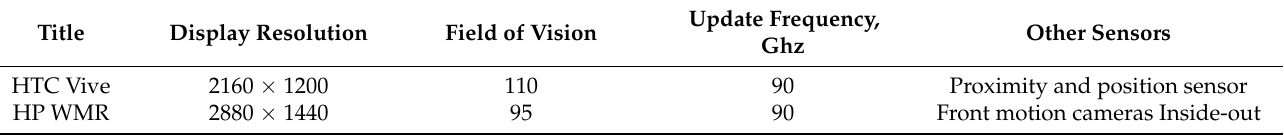
Table 2. Comparative characteristics of virtual reality